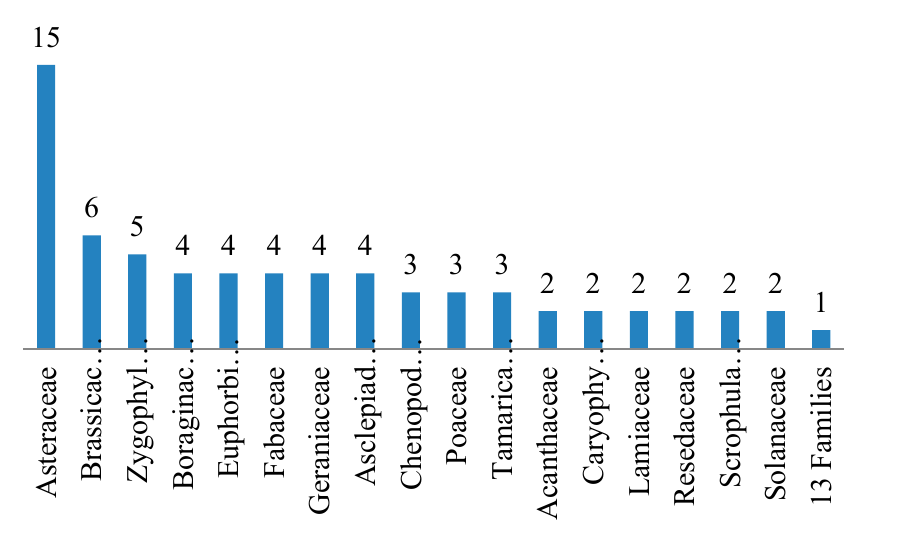
Figure 4. Life span of the species recorded in Wadi Hagul.